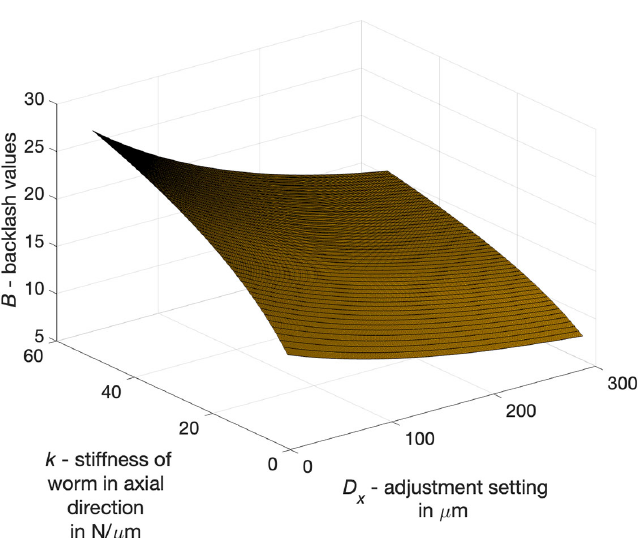
Figure 19. Backlash values B of worm gear drive as a function of the adjustment setting D x and worm stiffness k in the axial